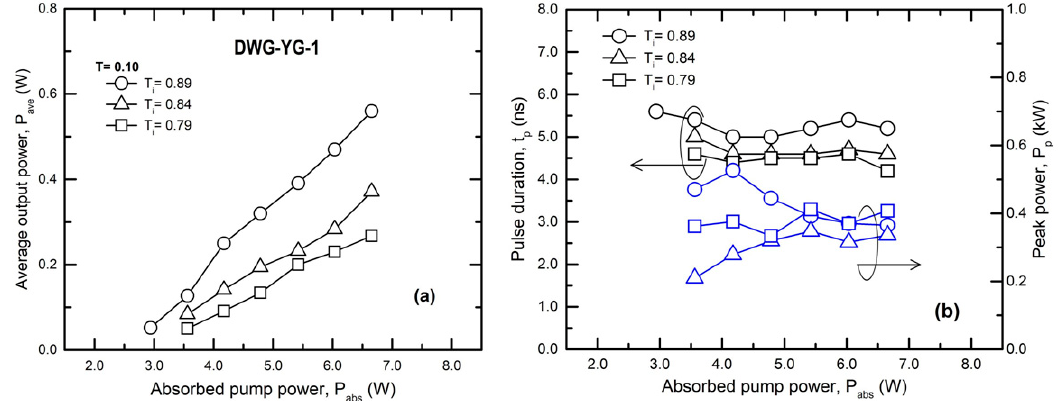
Figure 3. Q-switch operation for waveguide DWG-YG-1: ( a ) Average output power, P ave ; ( b ) Pulse duration, t p and laser pulse peak power, P p . T i : Initial transmission of Cr 4+ :YAG SA.